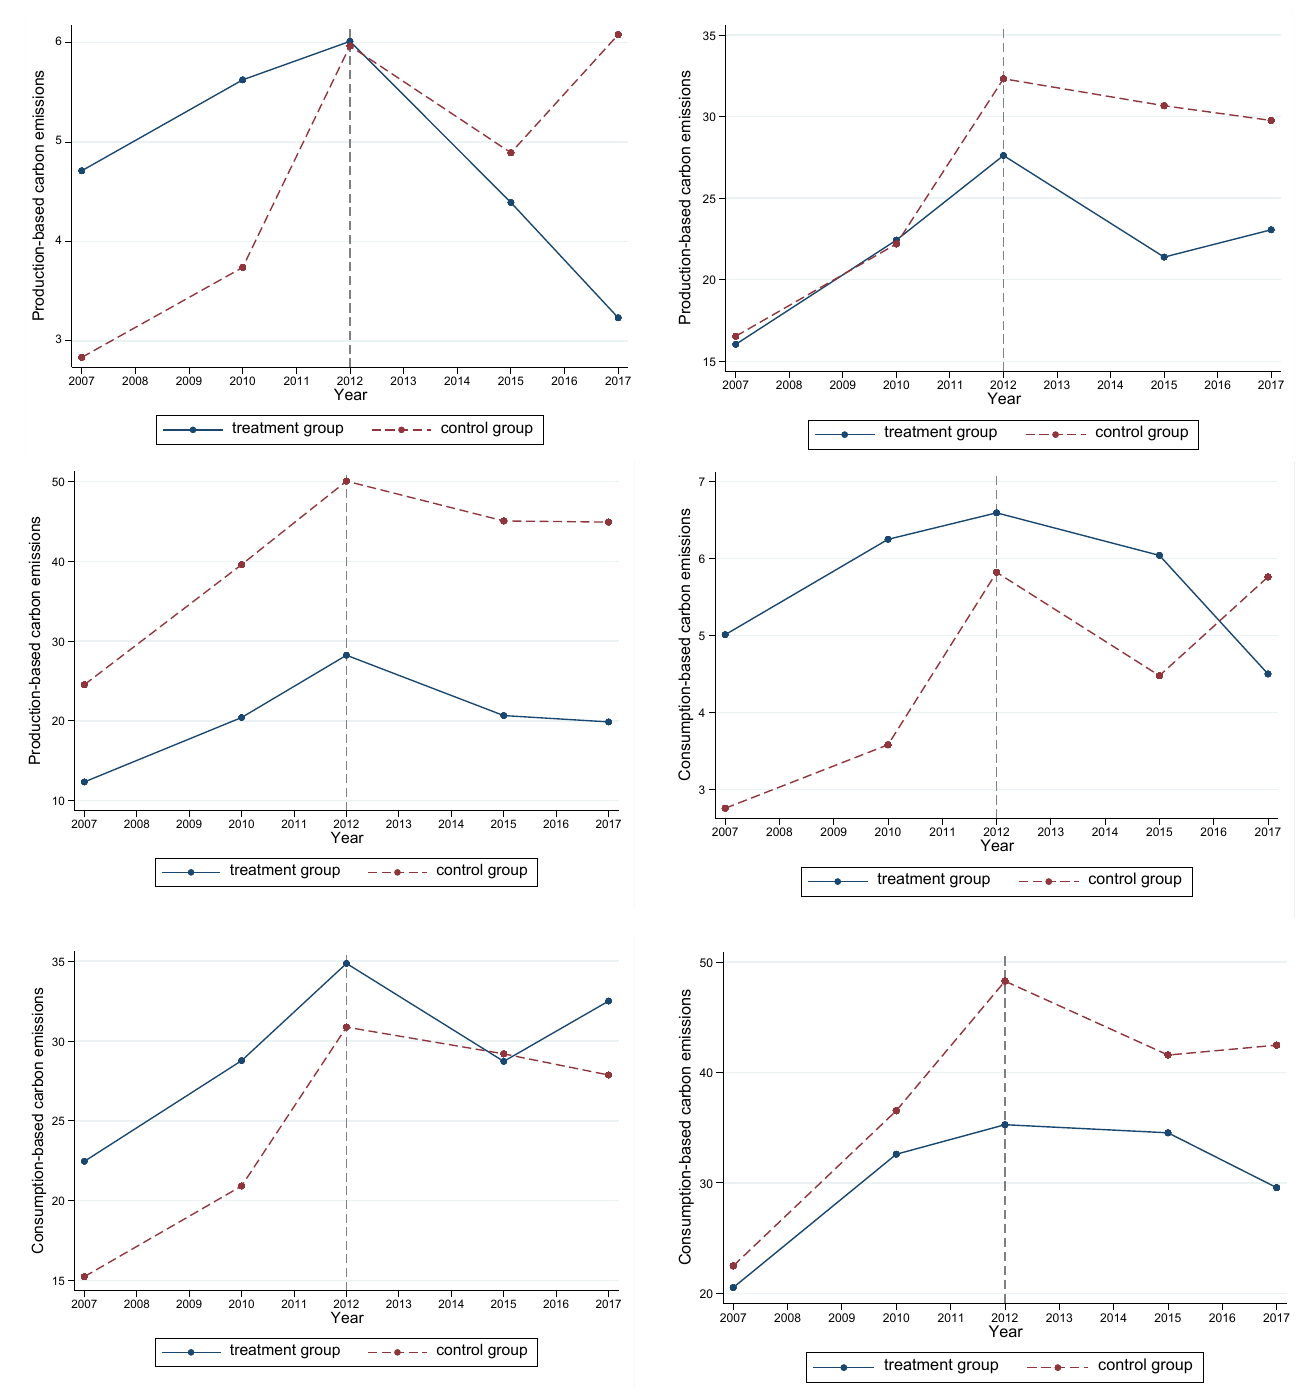
Figure 2. Parallel-trend test: trend over time. The first three figures are the test results of the parallel trend of production-based carbon emissions of the chemical, building materials, and metal industries, respectively. The following three figures are the test results of the parallel trend of consumption-based carbon emissions of the chemical, building materials, and metal industries, respectively. Based on Figure 2, before the introduction of the policy, the trends in the carbon non-pilot areas over time were roughly the same. As shown in Figure 3, the interaction dummy variables before 2012 was not significant. Both methods showed that the carbon control groups passed the parallel-trend hypothesis test.